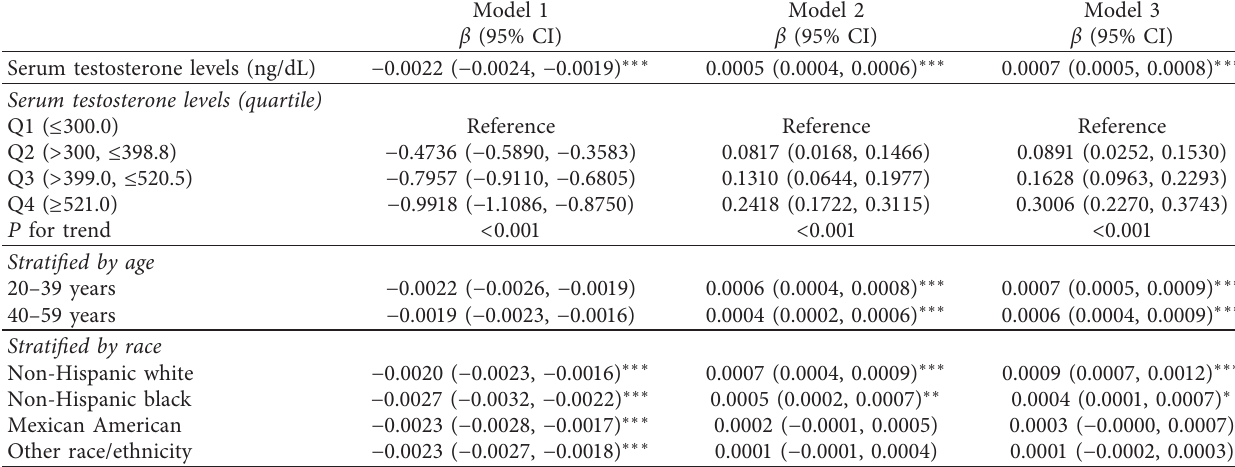
Table 3: Association between serum testosterone levels (ng/dL) and appendicular lean mass index (kg/m 2